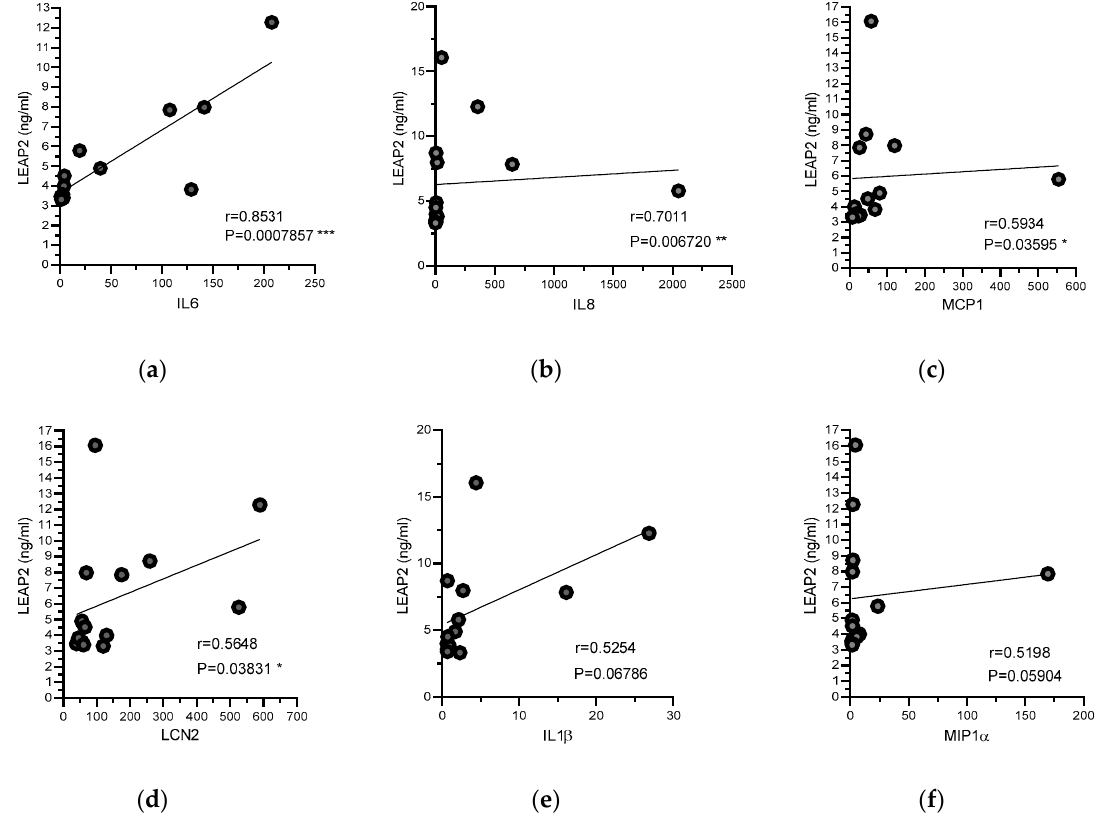
Figure 2. Relationships between levels of serum LEAP2 and proinflammatory mediators. Plasma levels of LEAP2 protein (ng / mL), as well as pro-inflammatory cytokines, were measured in RA-treated patients as described in methods. Relationships between LEAP2 serum levels and ( a ) IL6, ( b ) IL8, ( c ) MCP1, ( d ) LCN2, ( e ) IL1 β , and ( f ) MIP1 α were determined. Data were analyzed by Spearman’s correlation test (r). * p < 0.05, ** p < 0.01, *** p < 0.001.